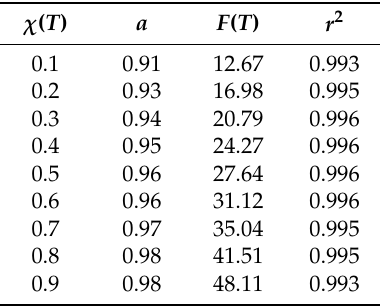
Table 2. Values of kinetic parameters at a given crystallinity estimated from the combined model [35] for non-isothermal crystallization of